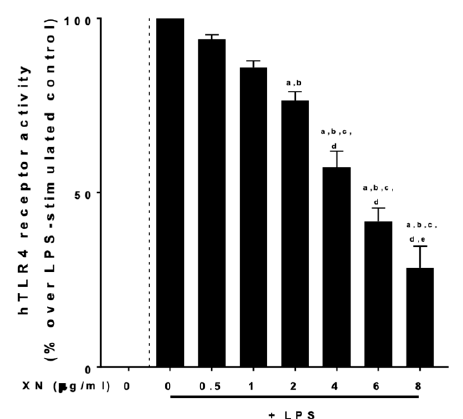
Figure 5. Receptor activities of HEK293 cells co-stimulated with LPS and XN for 12h. HEK293 cells were stimulated with LPS (100 ng/mL) and increasing concentrations of XN (0–8 µ g/mL) for 12 h. LPS, lipopolysaccharide; XN, xanthohumol derived through a XN-rich hop extract. Data are expressed as means ± SEM. a = p < 0.05 compared to 0 XN + LPS, b = p < 0.05 compared to 0.5 XN + LPS, c = p < 0.05 compared to 1 XN + LPS, d = p < 0.05 compared to 2 XN, e = p < 0.05 compared to 4 XN + LPS.